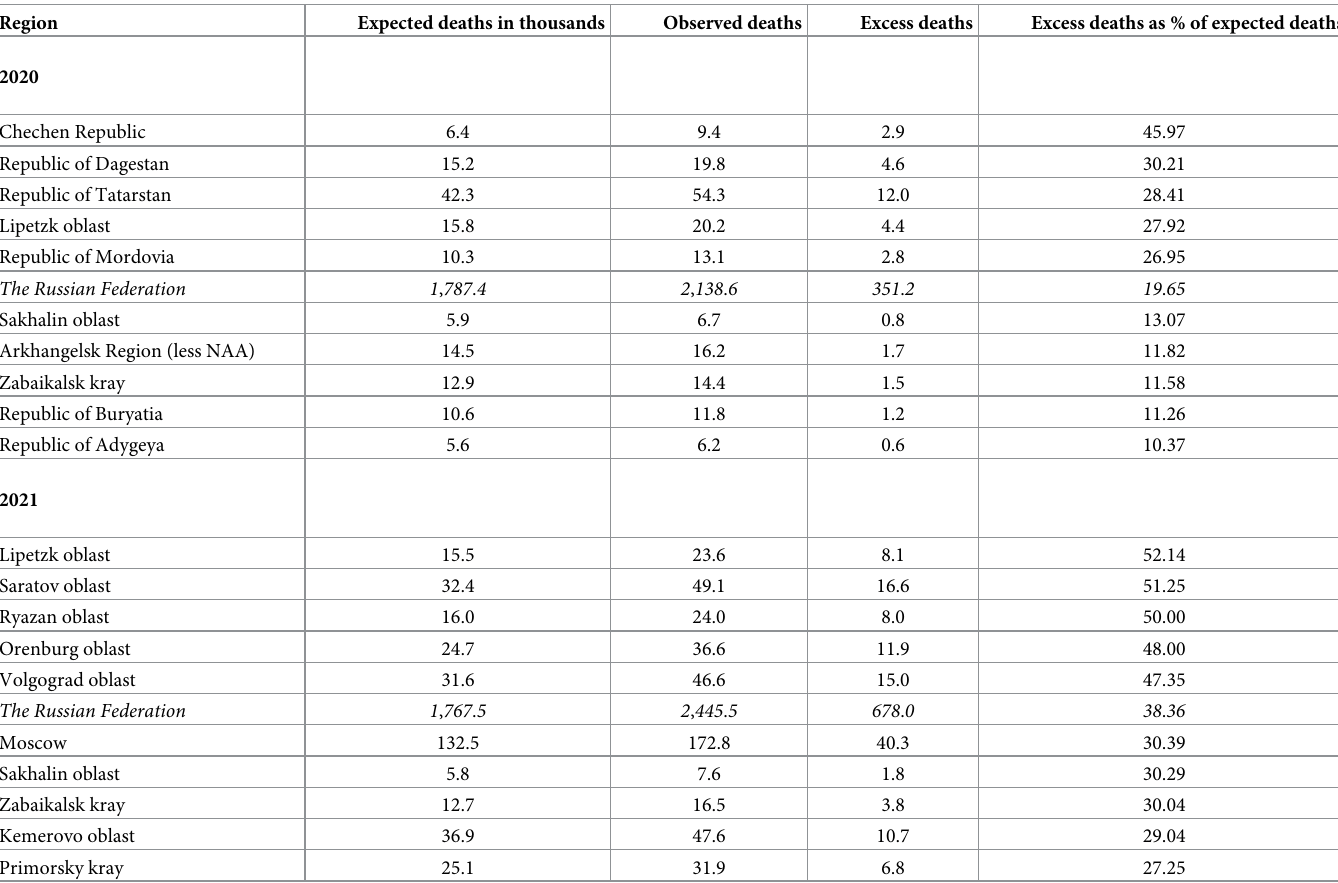
Table 1. Expected, observed and excess deaths (expressed in absolute and percentage terms), highest and lowest five regions of the Russian Federation with greater than 3,000 predicted deaths per year, 2021 and 2020, ranked by excess deaths as % of expected deaths.